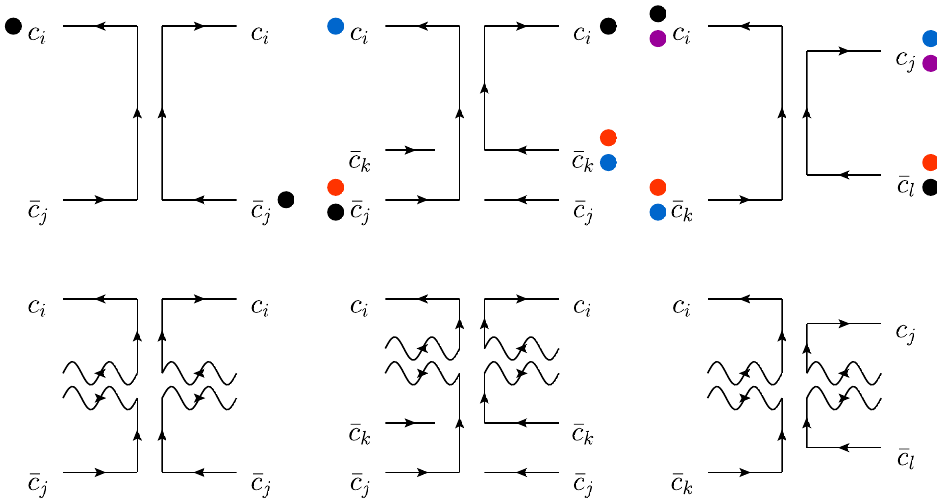
Figure 1 . The colour flows in the density operator relevant for the emission of a gluon (the amplitude is drawn to the left and the conjugate amplitude to the right). Top row is before the emission and the bottom row is after (the emitted gluon’s colour lines are indicated as wavy lines). See text for more